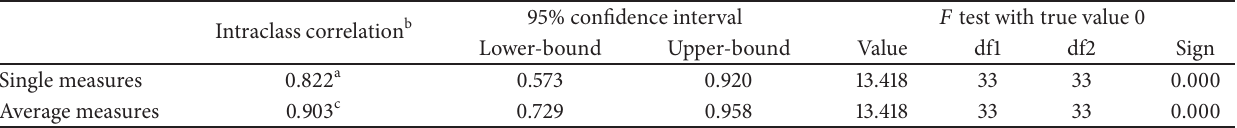
Table 3: Intraclass correlation coefficient (ICC).